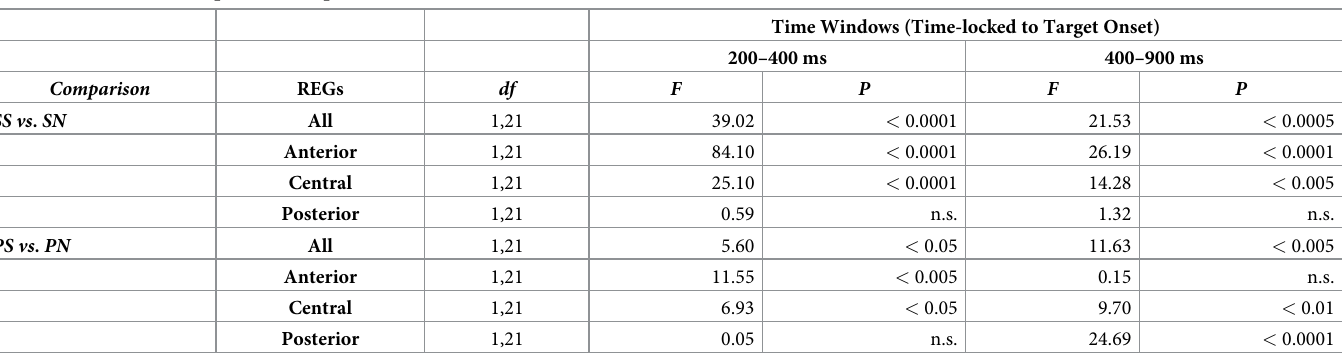
Table 7. Results of critical pairwise comparisons.